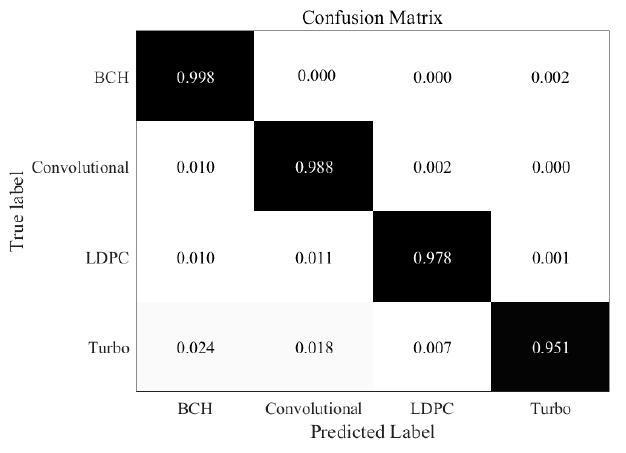
Figure 7. Confusion matrix for improved RNN trained at − 5 dB SNR.